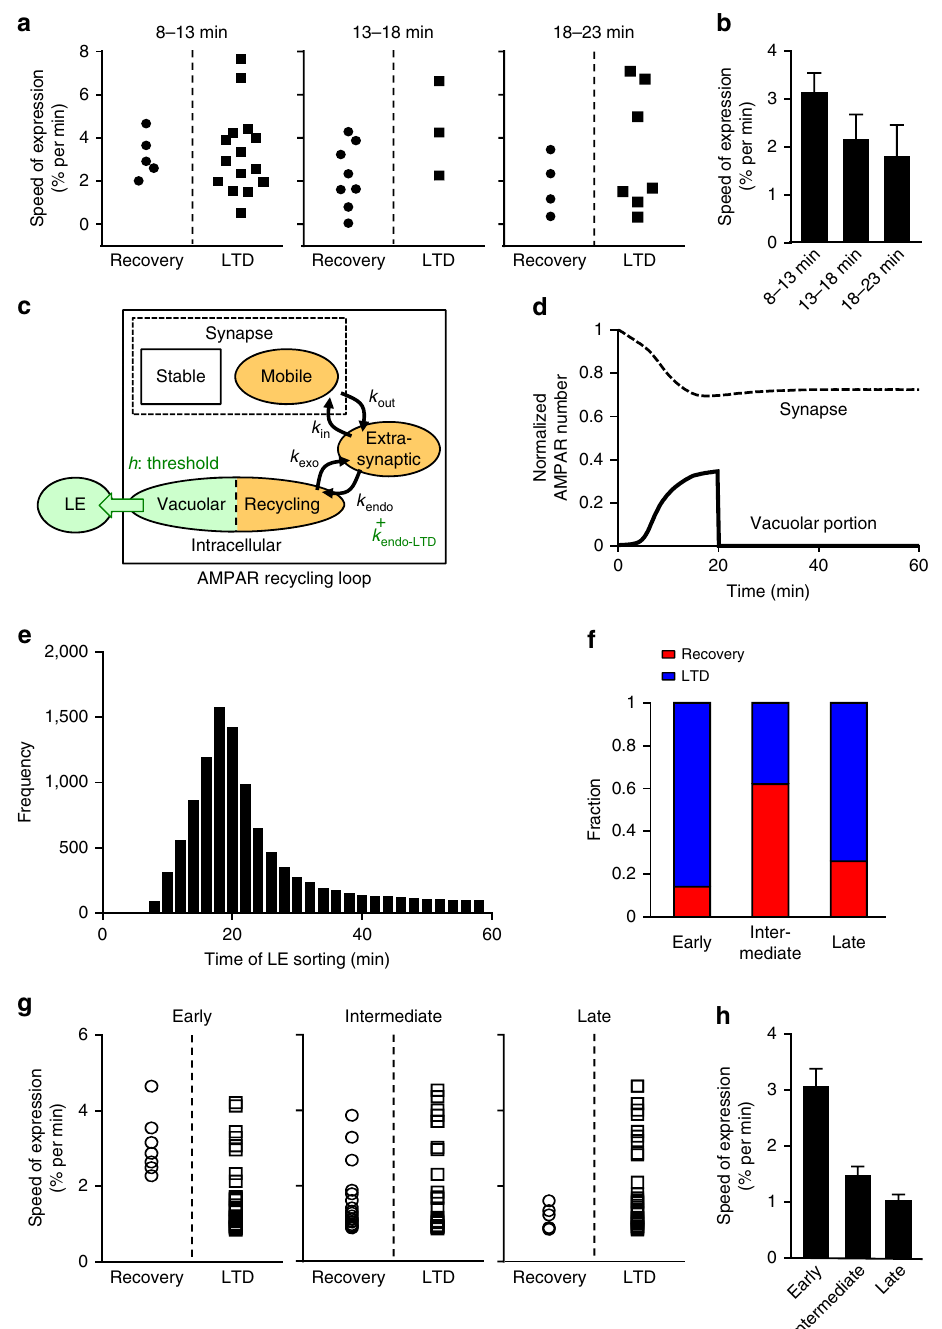
Fig. 8 Combination of the speed of LTD expression and the threshold of LE sorting produces variability in the timing of LE sorting. a Experimental analyses of the speed of LTD expression (% reduction of PF-EPSCs per min) in the recovery and LTD groups upon photoactivation of PS-Rab7TN at 8 – 13 min ( left ), 13 – 18 min ( middle ), or 18 – 23 min ( right ). b Averaged speed of LTD expression in the recovery group. c Diagram of the advanced model. The switch-like behavior of LE sorting with a threshold ( h ) and an intracellular compartment destined for LE were added. The value of k endo was increased to mimic LTD expression (addition of k endo-LTD ). d An example of LTD ( dotted line ) and the accompanying accumulation of the vacuolar portion as well as sorting to LE of AMPARs ( solid line ) simulated by the model shown in c . The peak time of k endo-LTD ( τ ) and threshold of LE sorting ( h ) used here were 10 and 0.345, respectively. e A histogram showing the appearance frequency of each timing of LE sorting, simulated by the model with varied peak time of k endo-LTD ( τ ) and threshold of LE sorting ( h ). f Simulated fractions of recovery ( red ) and LTD ( blue ) groups. g , h Analyses of the speed of LTD expression (% reduction of PF-EPSCs per min) in the model. Individual speeds of the recovery and LTD groups g and the average speed of the recovery group h are shown. Results of the model shown in f – h are obtained from different sets of 50 examples picked by simple random sampling, among all possible examples as shown in the histogram